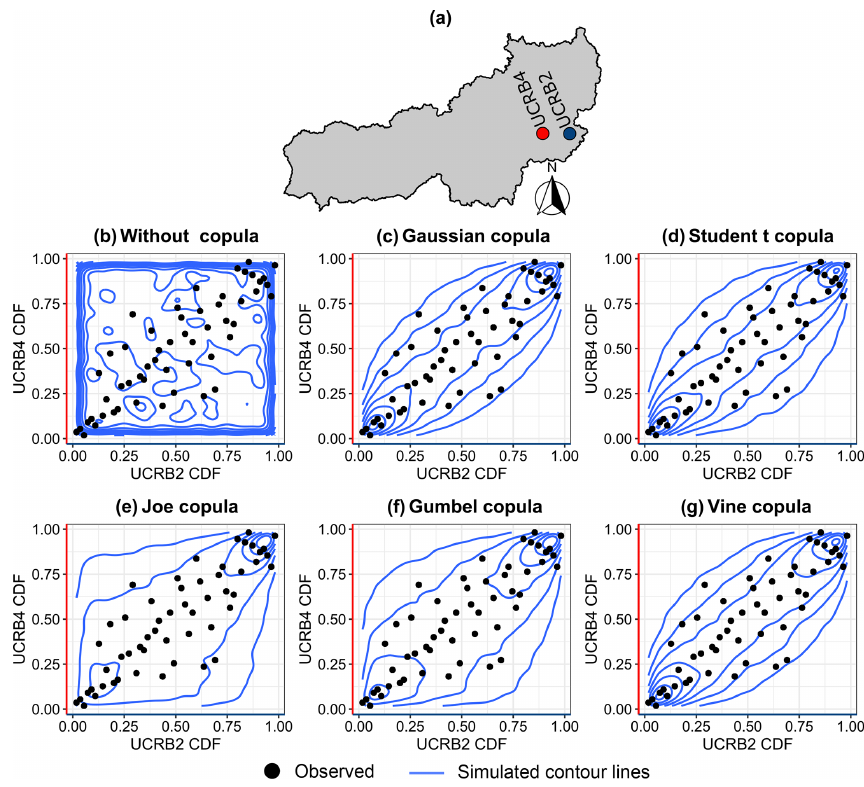
Figure 7. Pairwise dependence structure between UCRB2 and UCRB4 (a) streamflow simulated (b) without a copula and with a (c) Gaussian copula, (d) Student t copula, (e) Joe copula, (f) Gumbel copula, and (g) Vine copula. Observations and simulated contour lines are shown as black points and blue lines,